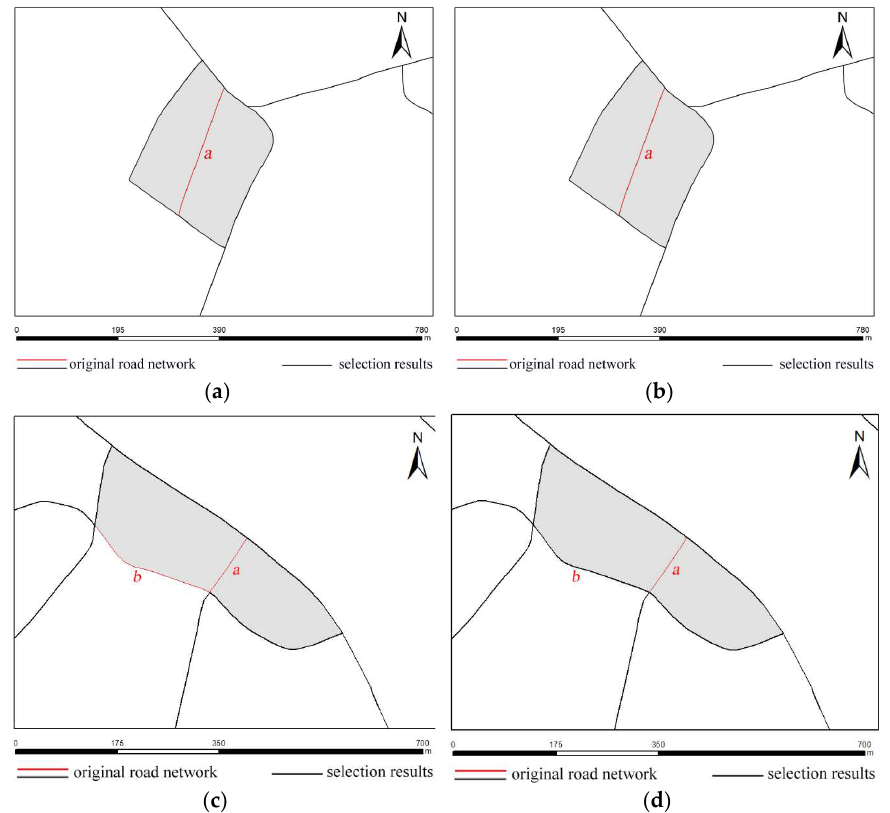
Figure 12. Comparison of two typical aggregated areas with two small meshes: ( a ) Selection